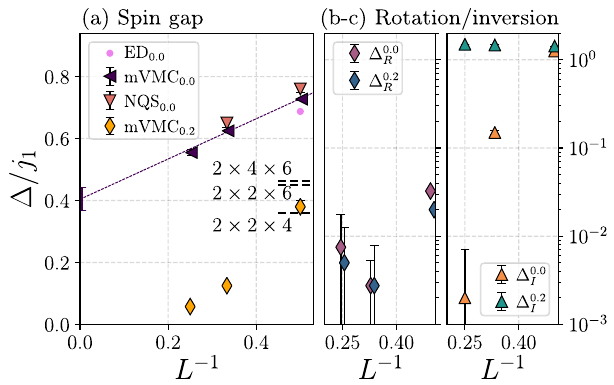
FIG. 4. Spin- or space-group spectroscopy at the SU ð 2 Þ - symmetric point. (a) Triplet gap as a function of inverse linear system size L . Data points labeled ED 0 , NQS 0 [difference . 0 . 0 between even and odd spin sectors projected using Eq. (7)], and mVMC 0 represent the spin gap at j 2 =j 1 ¼ 0 . 0 obtained within . 0 ED, NQS, and mVMC, respectively, while mVMC 0 shows the . 2 vanishing spin gap at j 2 =j 1 ¼ 0 . 2 . Dashed lines on the right represent values obtained at nonequilateral clusters within mVMC at j 2 =j 1 ¼ 0 . 0 . The error bar at L − 1 ¼ 0 represents 1 = 4 of the difference between extrapolation and the value obtained on the largest possible cluster. The data can be found in Table II of Appendix H. (b,c) Point-group symmetry gaps as a function of the inverse linear system size L − 1 obtained within mVMC. Data points labeled Δ 0 . 0 R , Δ 0 . 0 I show the rotation and inversion gaps as j 2 =j 1 ¼ 0 . 0 , while Δ 0 . 2 R , Δ 0 . 2 I stand for the j =j 0 . 2 2 1 ¼